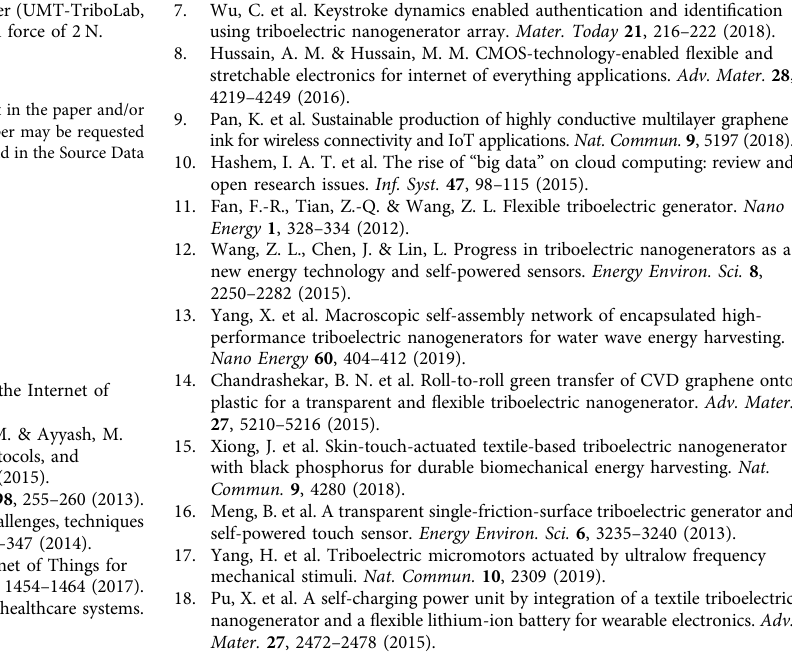
Data availability